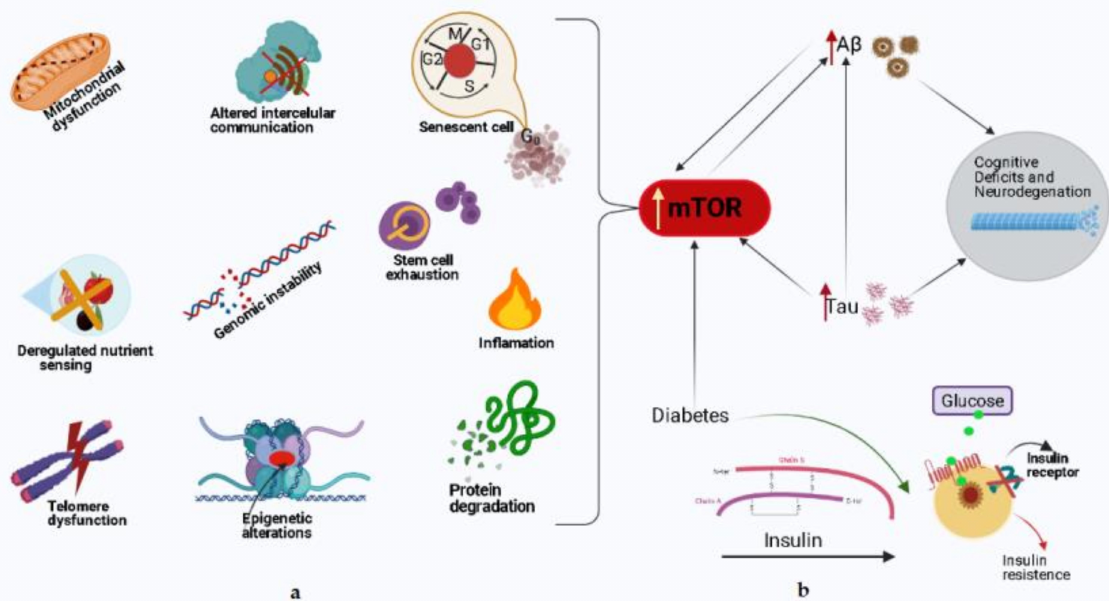
Figure 2. Schematic representation of mTOR hyperactivity in cognitive aging and AD. ( a ) Left—The implications of mTOR in main processes of aging. These features of aging, to different degrees, lead to an increased risk for AD, as well as cognitive decline during normal aging. Rapamycin and other pharmacological approaches that decrease mTOR activity may be valuable for delaying AD progression. ( b ) Right—The interrelation between neuropathological hallmarks of AD and mTOR. Hyperactive mTOR increases the production of A β and tau; and many factors including diabetes may influence the crosstalk of these proteins, and the aberrant cycle it creates contributes to the pathogenesis of